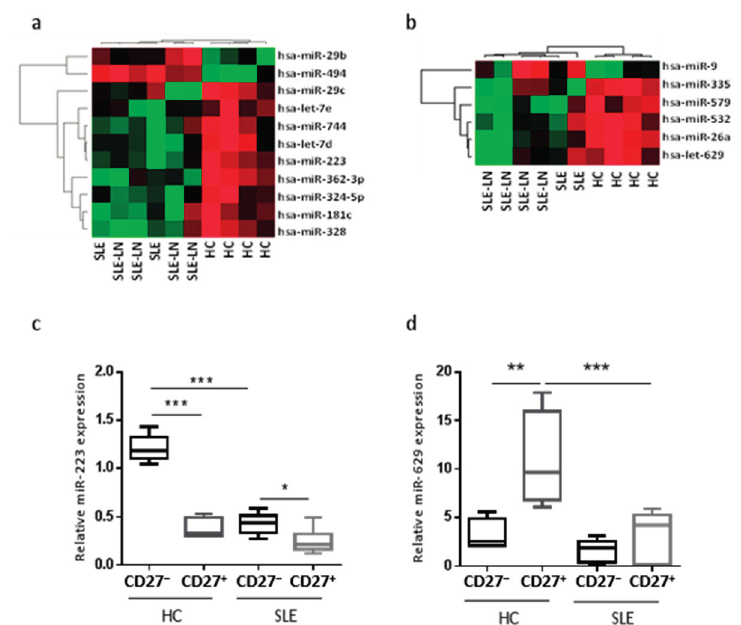
Figure 2. Unforced hierarchical clustering of each B cell subset discriminated SLE and LN patients from HC (healthy controls). The heat map shows relative levels of miRNA expression in a red (low relative expression) to green (high relative expression) scale. Dendrograms indicate the correlation between groups of samples and miRNAs. Samples are in columns and transcripts in rows. Each row represents a single miRNA and each column represents an individual sample. Heatmaps for naive ( a ) or memory ( b ) B cells are shown and are ordered by the disease (six SLE patients versus four HC), and show the expression for the 11 or six most deregulated miRNAs, respectively. Expression levels of miR-223 ( c ) or miR-629 ( d ) in naive and memory B cells. Results are expressed as mean ± SD of individual sample patients. * p < 0.05, ** p < 0.01, and *** p < 0.001, one-way ANOVA, followed by a Tukey’s multiple comparisons